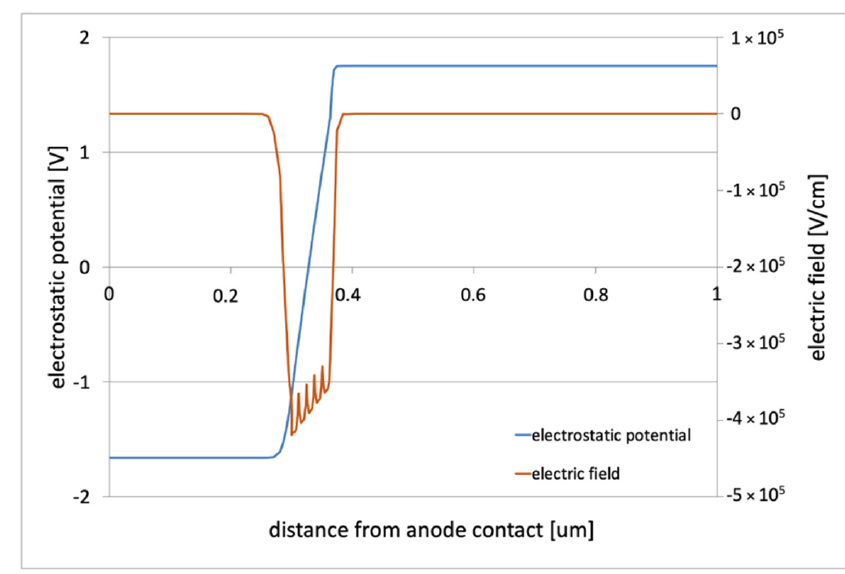
Figure 7. Potential and electric field distribution in the tested diodes: wide and narrow p-i-n diodes and in the LED: ( a ) p- ν -n with 5 µ m wide ν -layer, ( b ) p- ν -n with 50 nm wide ν -layer, and ( c ) LED with 50 nm wide MQW-layer.